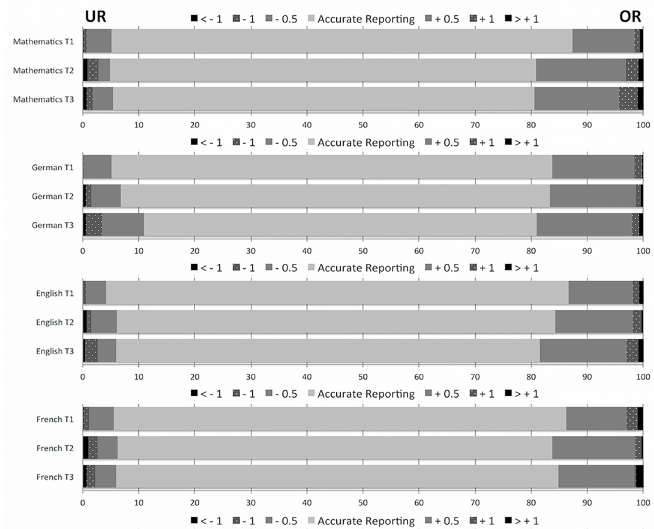
Fig 1. Cumulative percentages of mean differences between self-reported and actual grades. UR = Under-reporting; OR = Over-reporting.